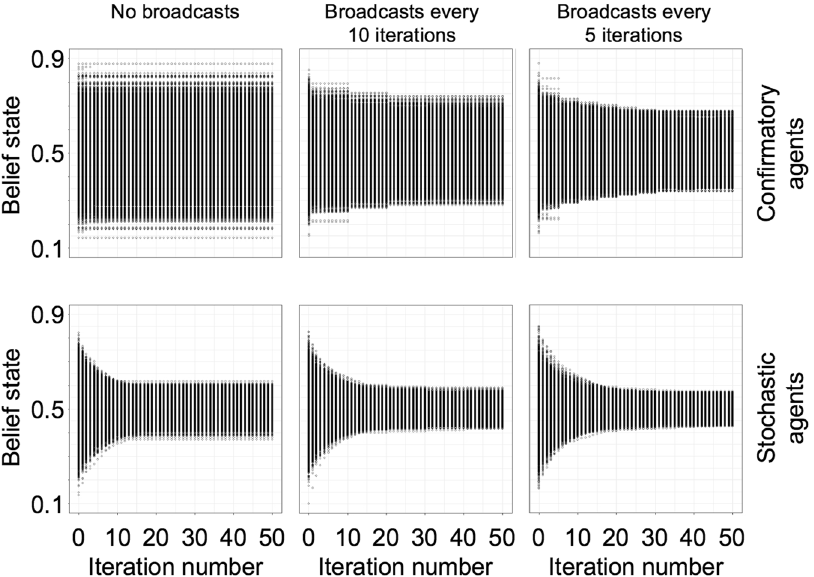
Figure 4. Distribution over the mean of agent beliefs over time when receiving educational broadcasting. Top row has confirmatory agents ( β -value = 0.1), bottom row has stochastic agents with no confirmatory search parameter. Columns depict frequency of educational broadcasting (no broadcasting; every 5 ticks; every 10 ticks; every 20 ticks).